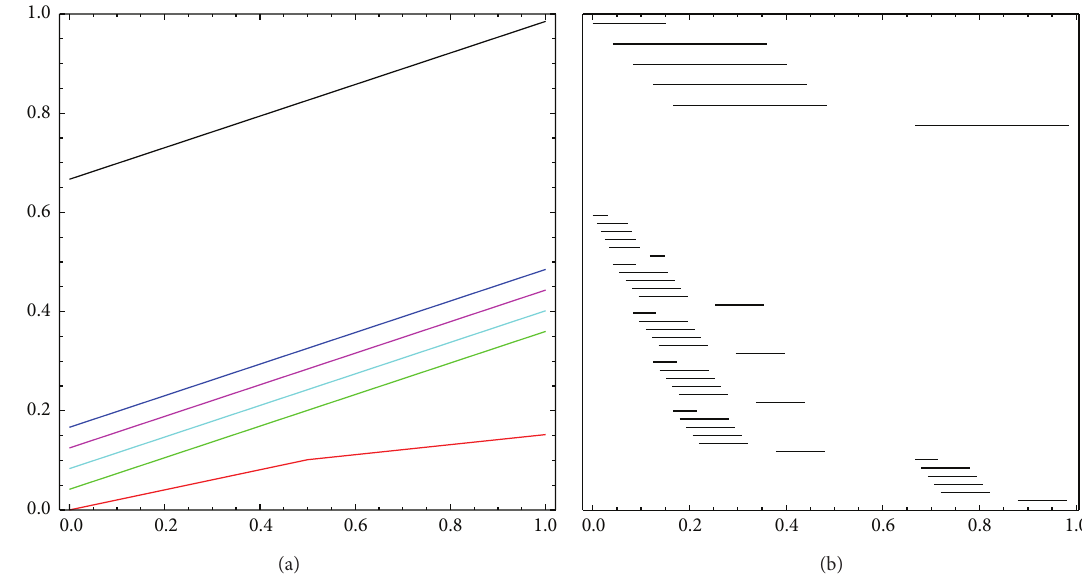
Figure 2: (a) Graphs of the maps in the IFS in (90). (b) First two levels of iterations of the interval [0, 1] under the IFS.